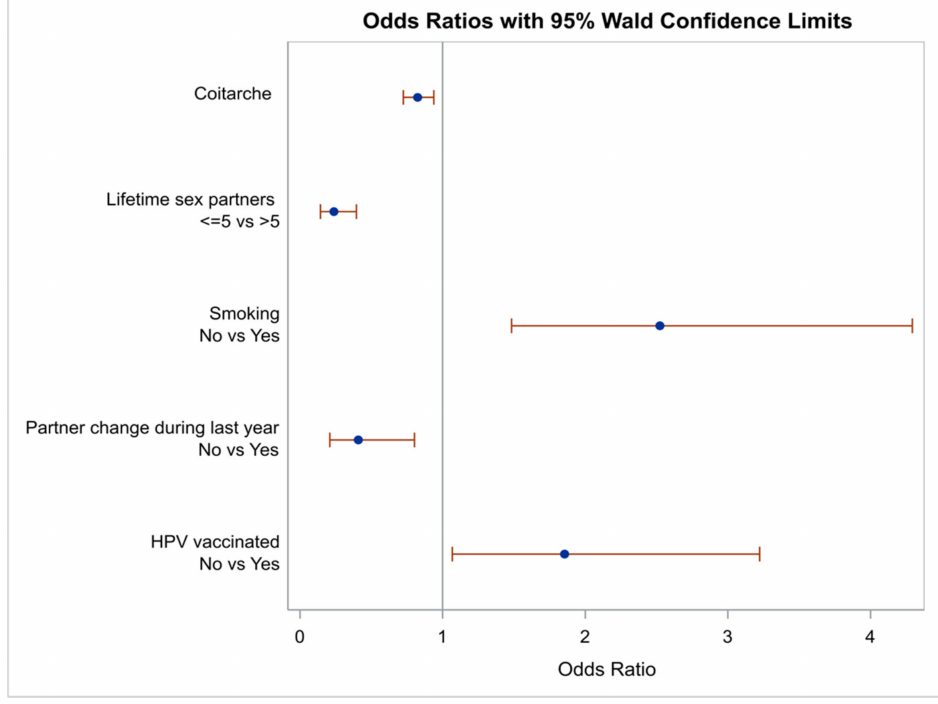
Figure 2. Odds ratios and 95% confidence limits of the demographic characteristics which were found important for DNA positivity at multivariate analysis. Note that ORs are the reciprocal of the ORs for positive test